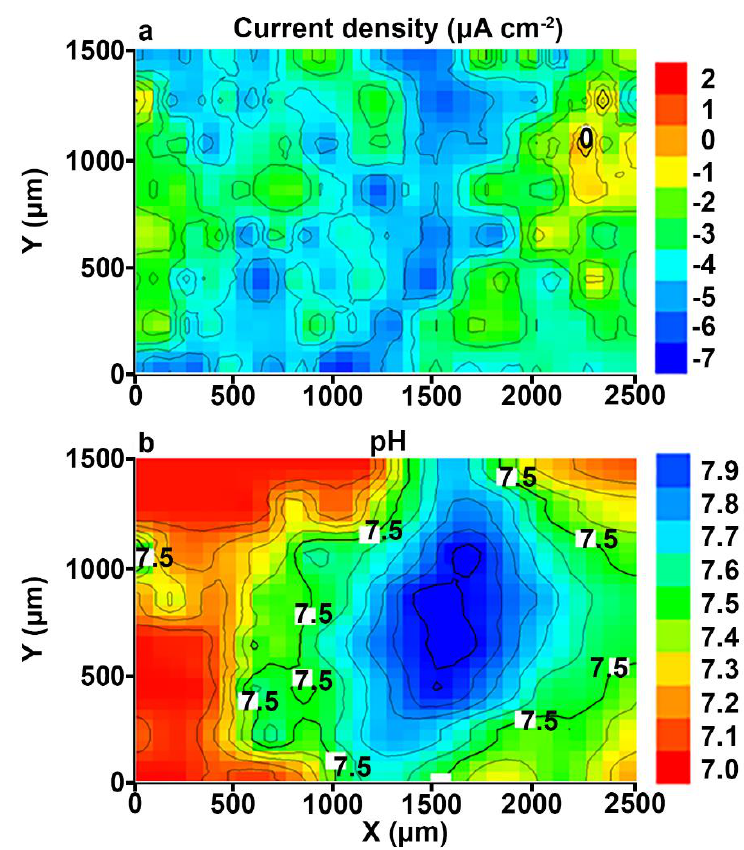
Figure 3. The ( a ) SVET and ( b ) SIET diagrams of the current density and pH distribution at the surface of the welded joint area of the 1579 aluminium alloy sample with PEO-coating after 510 min of exposure to 0.5 M NaCl. The weld interface is a cathodic zone.